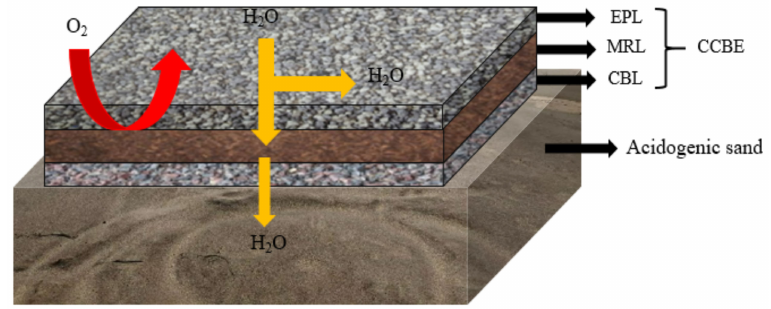
Figure 3. Schematic diagram of cover with capillary barrier